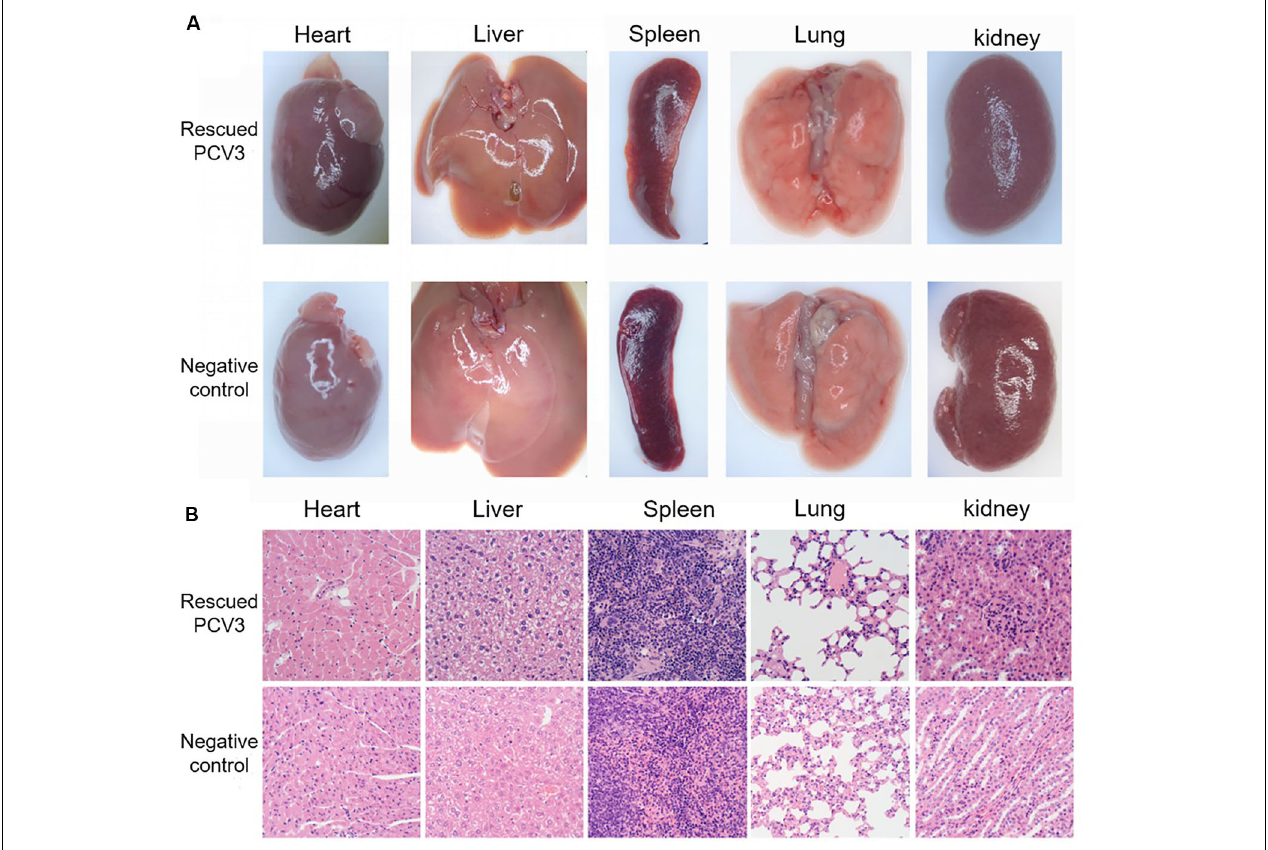
FIGURE 7 | Clinical symptoms and histopathological analysis of organs in the PCV3-inoculated KM mice. (A) Mouse tissue anatomy. There were no noticeable differences between KM mice inoculated with PCV3 and normal KM mice in the morphology of tissue changes. (B) Tissue section results. The heart, liver, spleen, lung and kidney sections from no PCV3-inoculated KM mice exhibited normal morphology. Lung lesions from PCV3-inoculated KM mice showed local alveolar wall vascular dilatation and interstitial pneumonia, and no significant changes in other tissues.